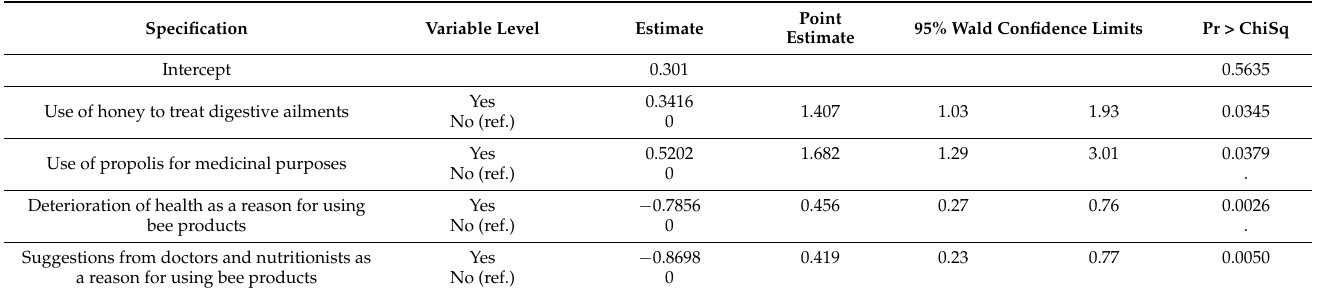
Table 8. Association of nutritional knowledge with bee products-related consumer behaviour (logistic regression